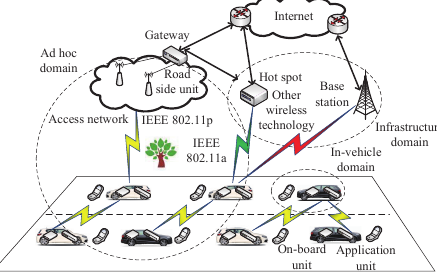
Figure 4. Communication domains in vehicular ad hoc